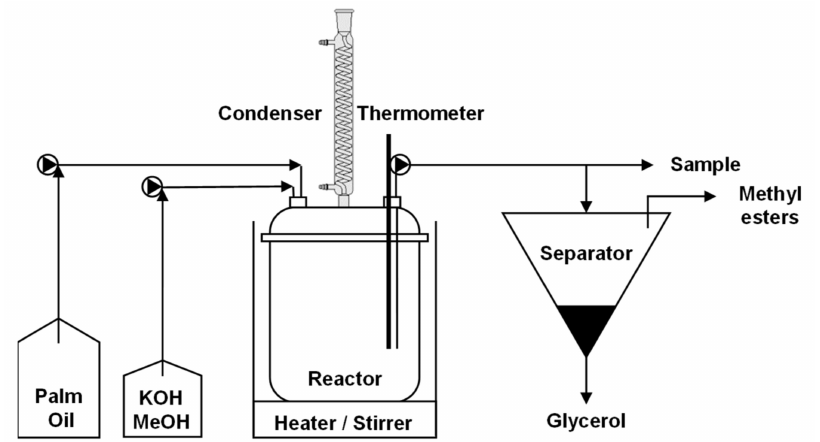
Figure 26. Continuous stirred-tank reactor